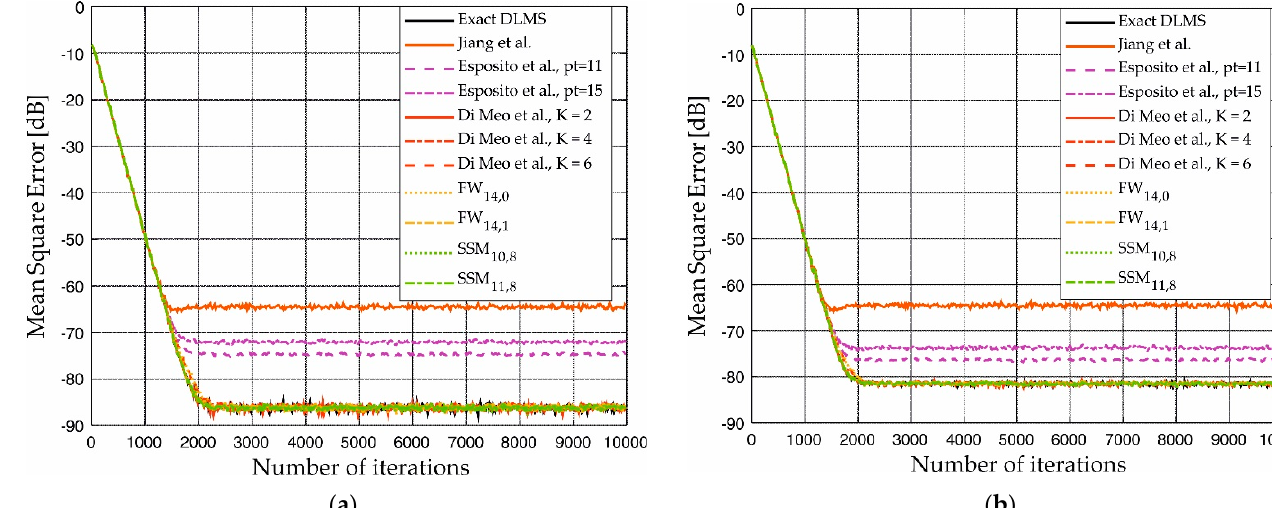
Table 2. Regime MSE with approximation in the FIR section.